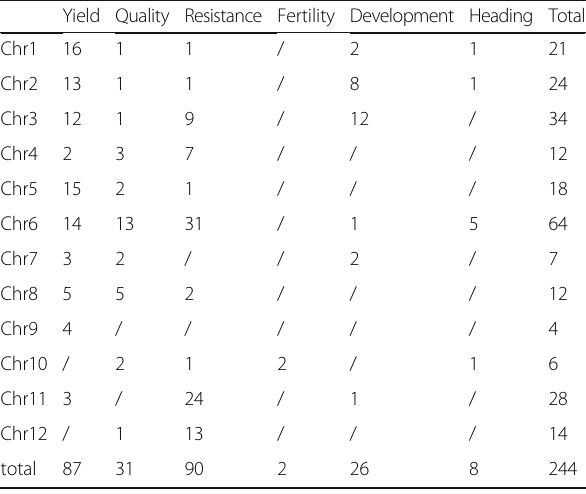
Table 3 Distribution of KASP markers associated with agronomic